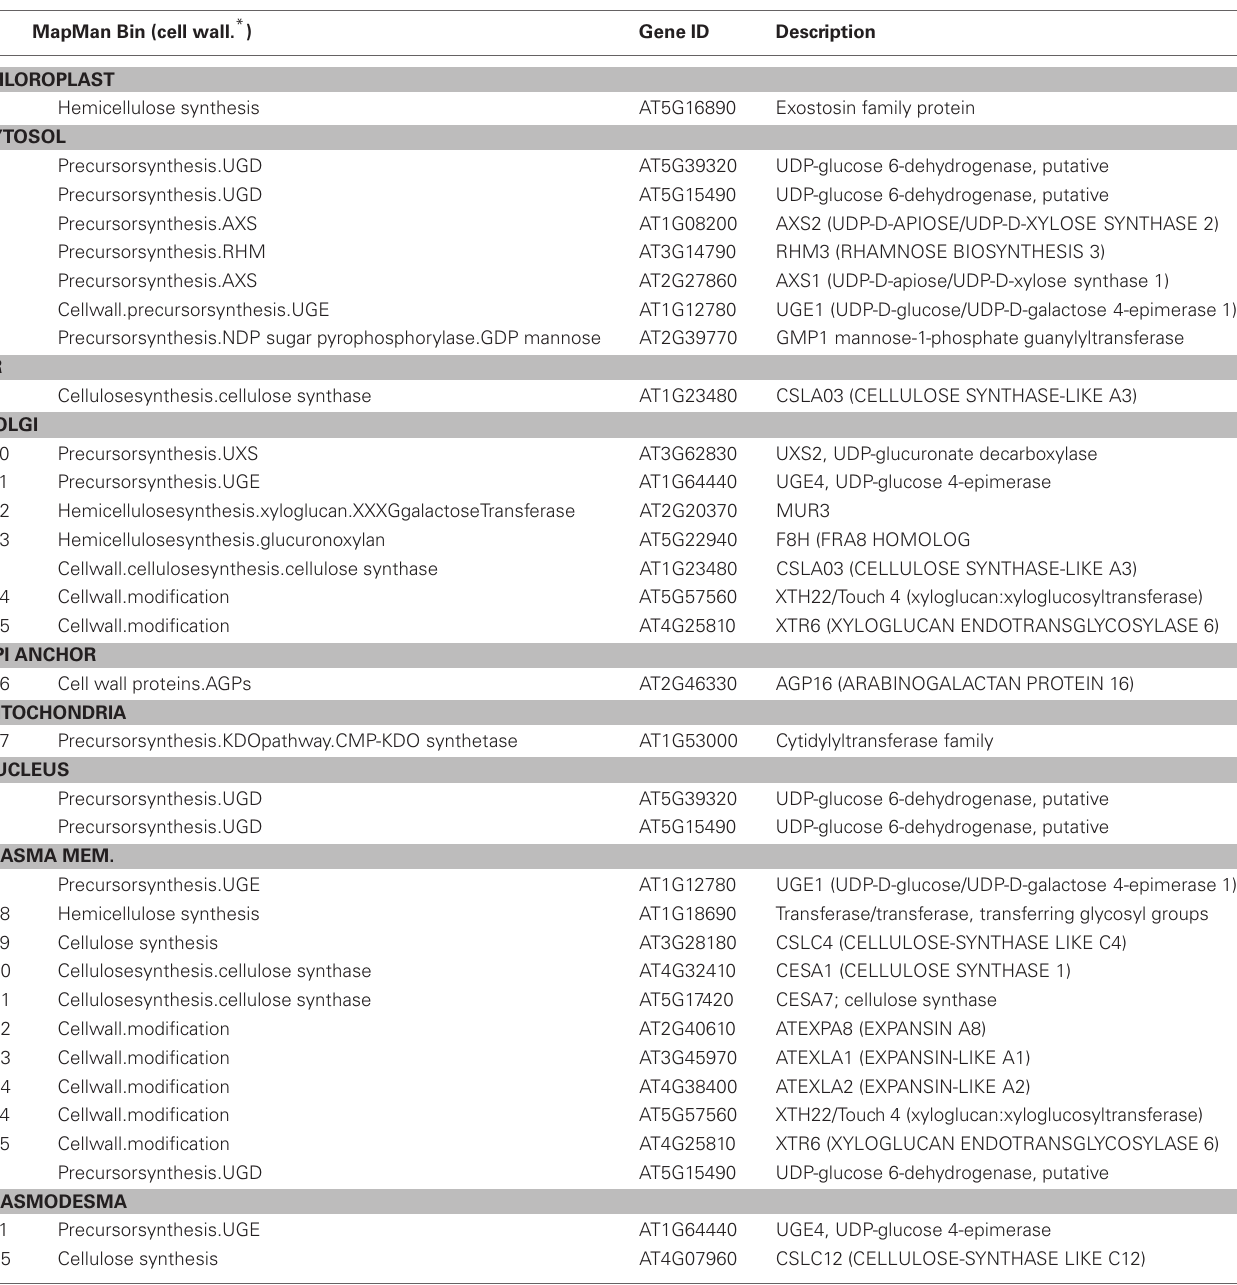
Table 2 | Cell wall associated protein